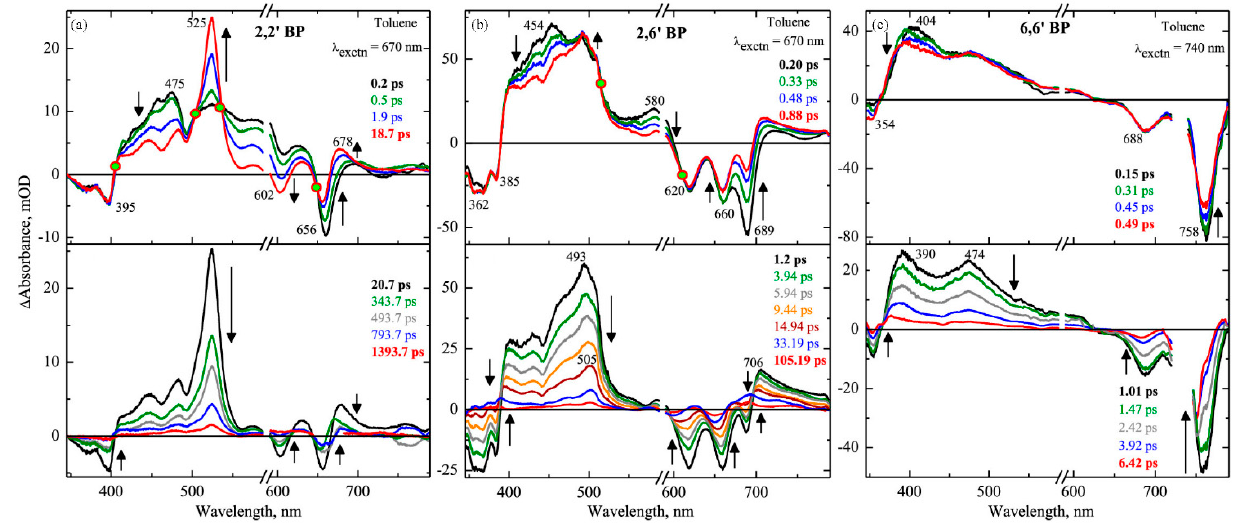
Figure 6. Femtosecond transient absorption spectra of ( a ) 2,2 ′ BP, ( b ) 2,6 ′ BP, and ( c ) 6,6 ′ BP in toluene obtained upon excitation at different delay times. Reprinted with permission from Ref. [79]. Copyright 2022, American Chemical Society. Table 2. Summary of time scales of the SF process in dimers.